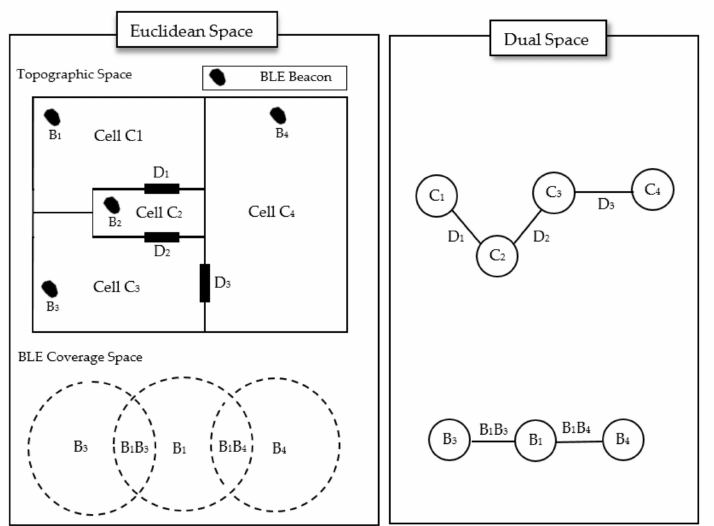
Figure 1. Representation of indoor cells and Bluetooth Low Energy (BLE) beacon coverage in Euclidian and dual space.